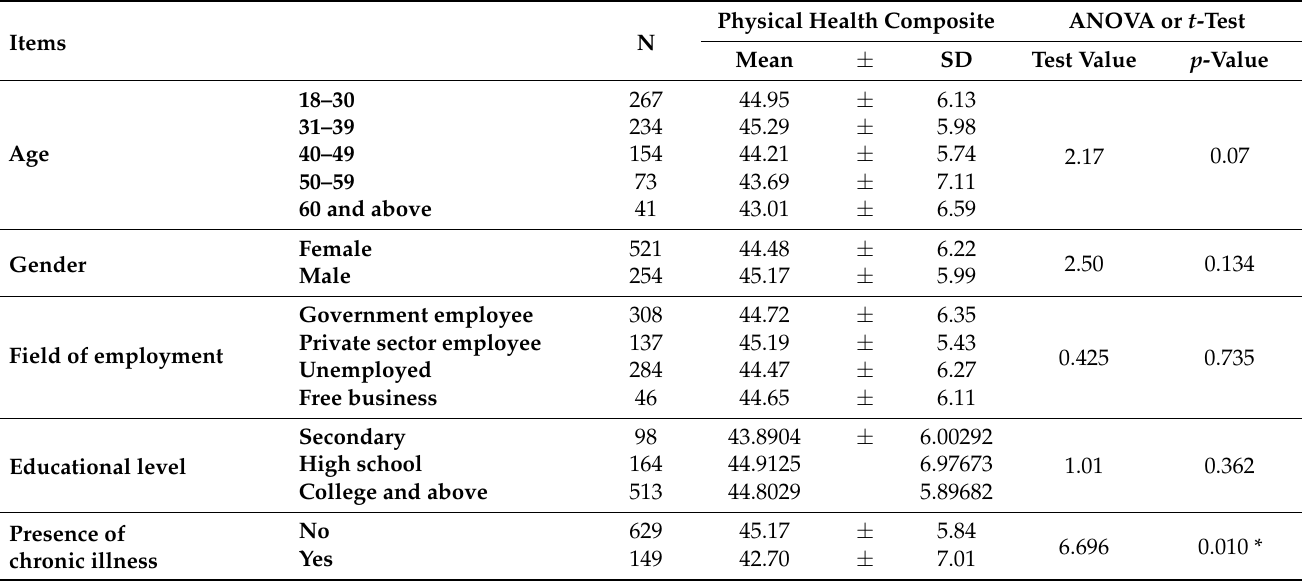
Table 6. Statistical differences between participants’ demographic characteristics and physical health (N =